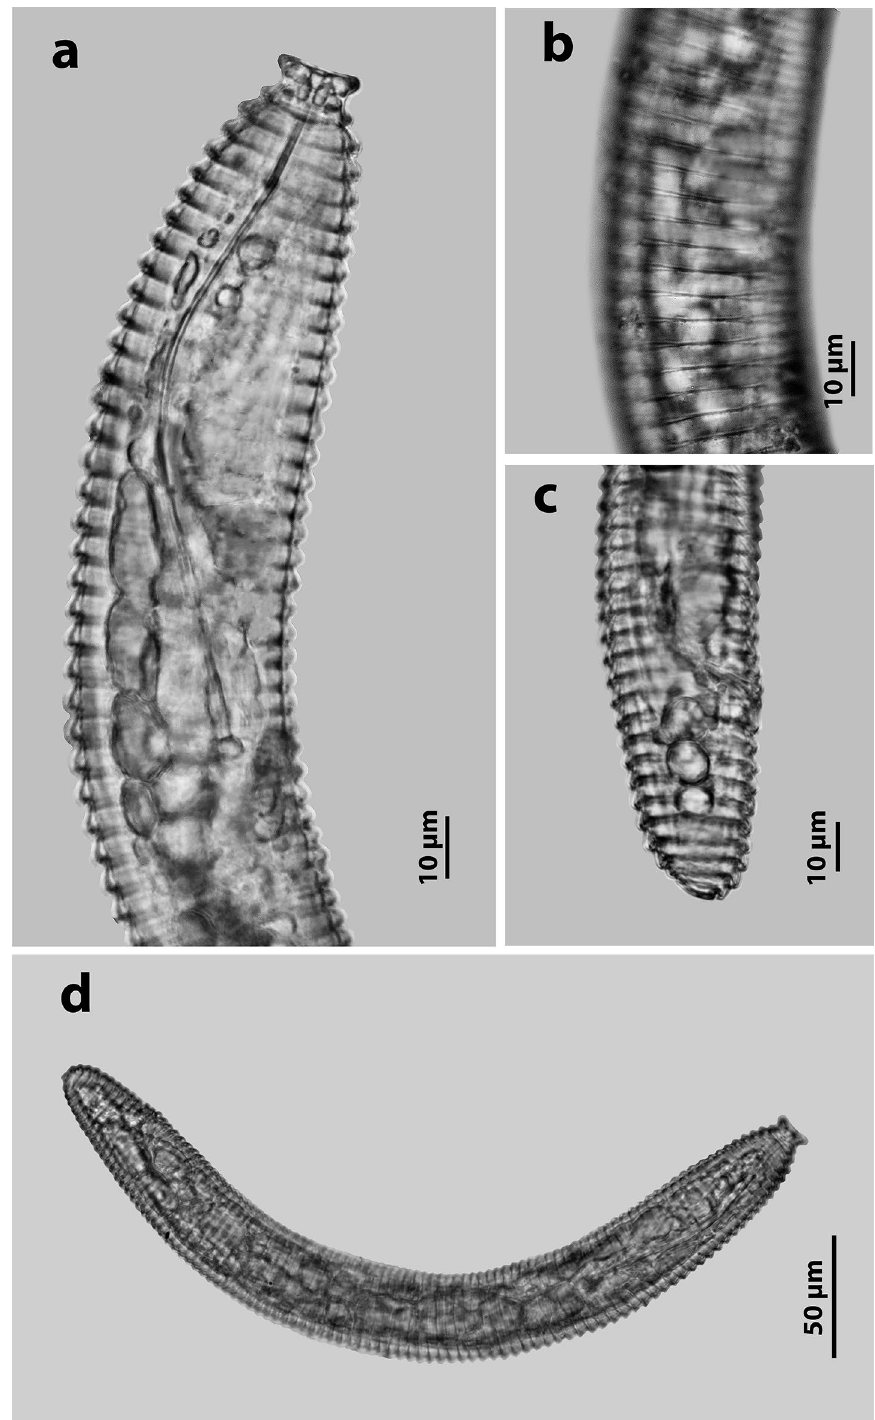
Figure 5. Female of Discocriconemella hengsungica from Vietnam. ( a ) Anterior end region. ( b ) Lateral field region. ( c ) Posterior end region. ( d ) Entire